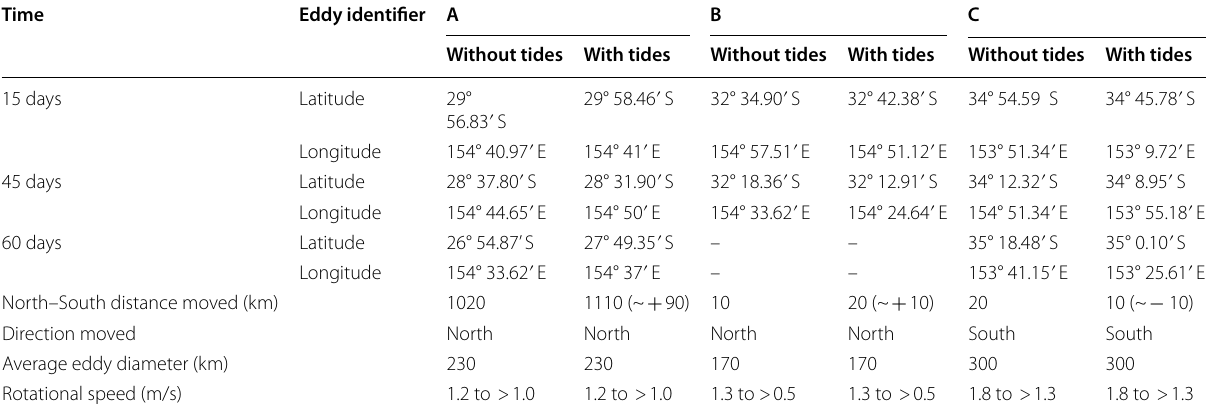
Table 1 Eddy center locations, North–South distance traveled, eddy diameter, and rotational speed between days 15 and 60 for the three main eddies at 15, 45, and 60